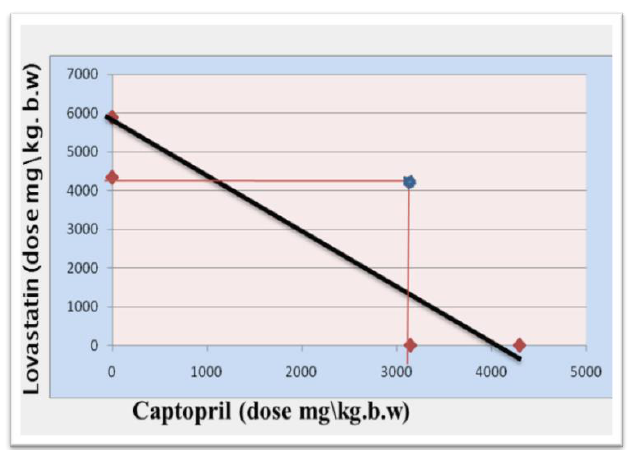
Figure 1. Isobolographic for interaction of acute toxicity between captopril and lovastatin